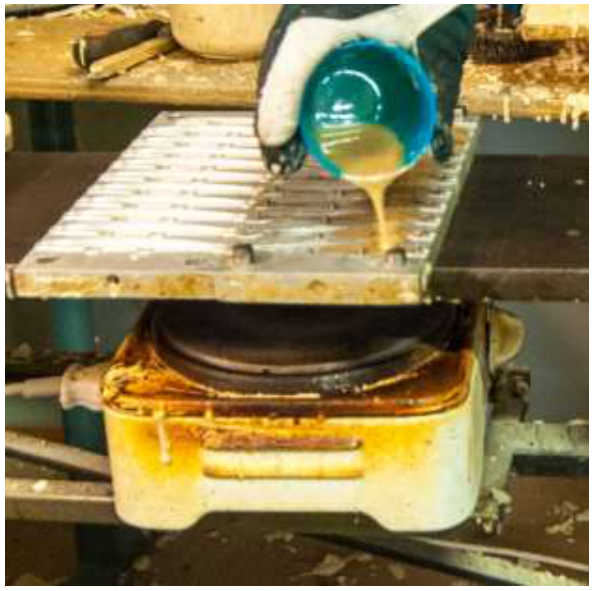
Figure 2. Molding mass poured onto a mold. The hotplate is seen